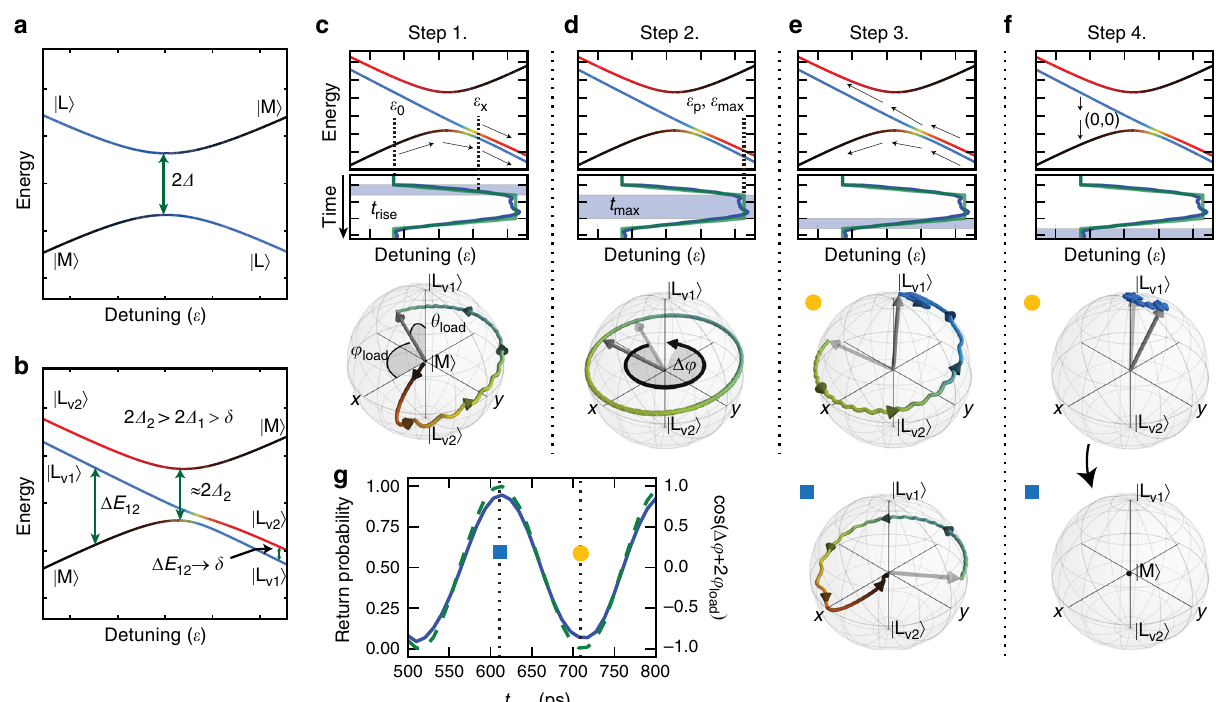
Fig. 2 Principle of operation and read-out. a The two-state spectrum of a standard charge qubit Hamiltonian with tunnel coupling Δ , and without valley states. b The three-state spectrum in the presence of a small valley splitting, δ (Not to scale). The same coloring is used in these spectra as in Fig. 3b and d. c – f The steps of qubit operation: The detuning as a function of time is shown as a solid green line in relation to the three state spectrum (solid blue line shows a realistic pulse pro fi le). The blue shaded region of time is the portion of the pulse that makes up a given step. Also shown is the evolution of the state during each step within the Bloch sphere of the left dot valley states. The paths have been colored in the same manner as the spectra. c In step 1, the loading step, the detuning ramps up over a time, t rise , from its initial value, ε 0 , through a level crossing at ε x . The fi nal state has Bloch coordinates θ load and ϕ ε ε fi cient duration) for a time t load . d In step 2, the accumulation step, the detuning stays at max ( p for pulses of suf max , during which time it accumulates a dynamical phase Δ ϕ . e In step 3, the read-out step, the detuning returns to ε 0 . Two state evolutions with different t max are shown, one labeled with a yellow circle and the other with a blue square. f In Step 4, the measurement/re-initialization step, the system relaxes to | M 〉 , aided by temporarily transitioning to charge con fi guration (0,0). g The simulated probability of the electron returning to state | M 〉 at the end of read-out is plotted along with cos( Δ ϕ + 2 ϕ load ) as a function of t max , showing that the total accumulated phase is encoded in the return probability. Also marked are the two values of t max for the evolution pathways displayed in f and g . The system marked with a yellow circle has accumulated an additional π radians of phase relative to the system marked